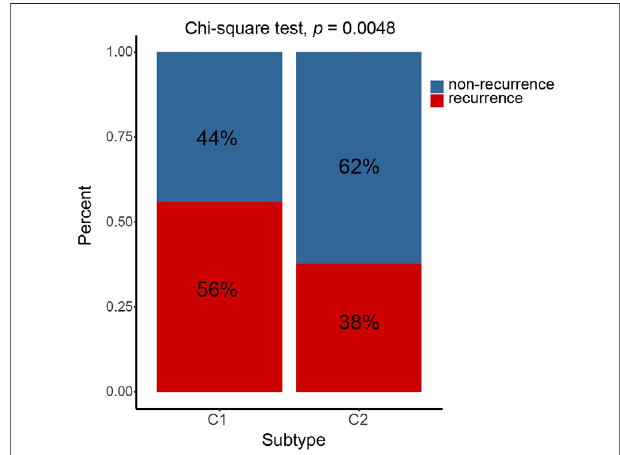
FIGURE 4 | C1/C2 has different recurrence rates in GSE62254 cohort. In GSE62254 cohort, C2 has lower recurrence rate (38%) than C1 (56%). The chi-squaretestresultsshowedasigni fi cantdifferenceintherecurrencerateof C1/C2 ( p (cid:1) 0.0048).